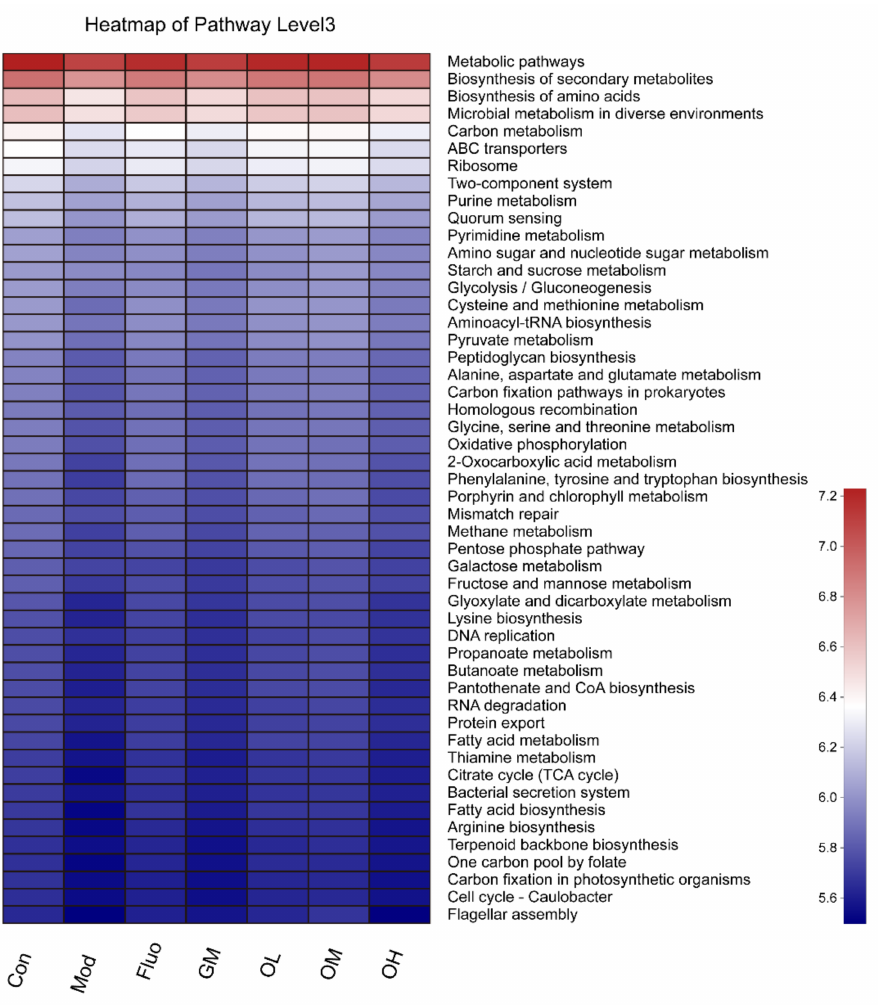
Figure 10. KEGG metabolic pathways enriched in the gut microbiota of CUMS